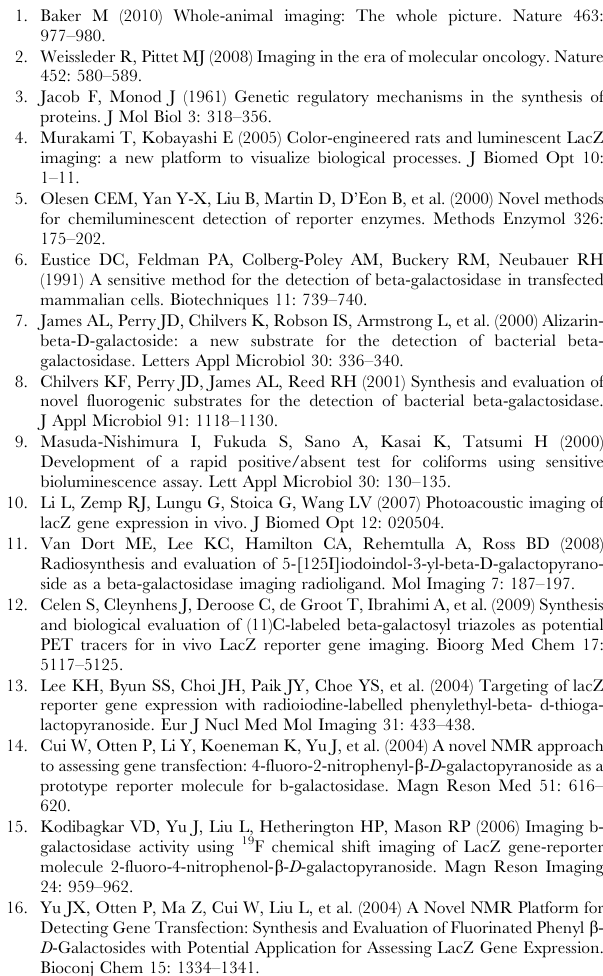
shows maximum light emission after about 5 mins with decay over the next 30 mins. Signal was much more intense than following IV injection. Figure S4 Detection of b -gal activity in organs of transgenic 129S-Gt (ROSA) 26Sor/J mouse by bioluminescence and b -gal staining. Left: BLI based on Galacto-Light Plus reveals lacZ expression ex vivo in various organs. Galacto-Light Plus mixture (25 m l) was injected into the tissue post mortem and detected with a 60 s exposure time. Right: Tissue surface staining after exposure to 1 mg/ml X-gal solution at 37 u C for 8 hrs. Bottom: b -gal activity detected in organs using colorimetric assay. Found at: doi:10.1371/journal.pone.0012024.s004 (0.50 MB